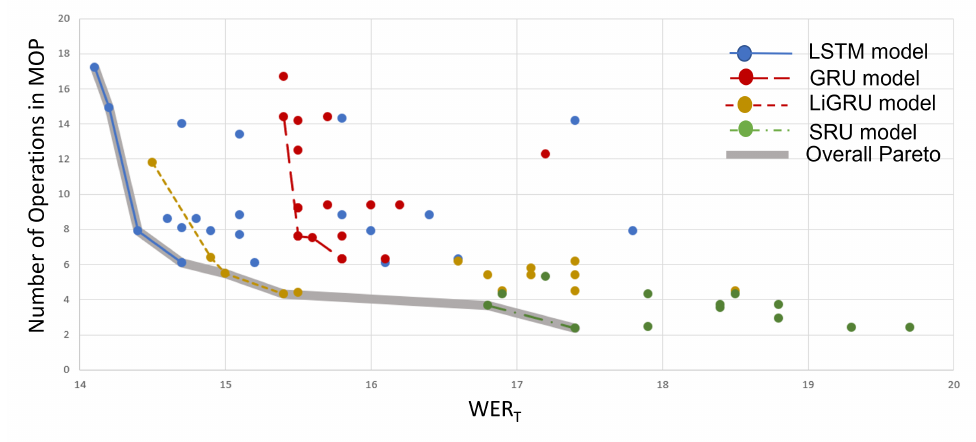
Figure 8. The number of operations in compressed models at different error levels. For each model, we connect the best points using a line. Then, we highlight the best points of all models with a gray